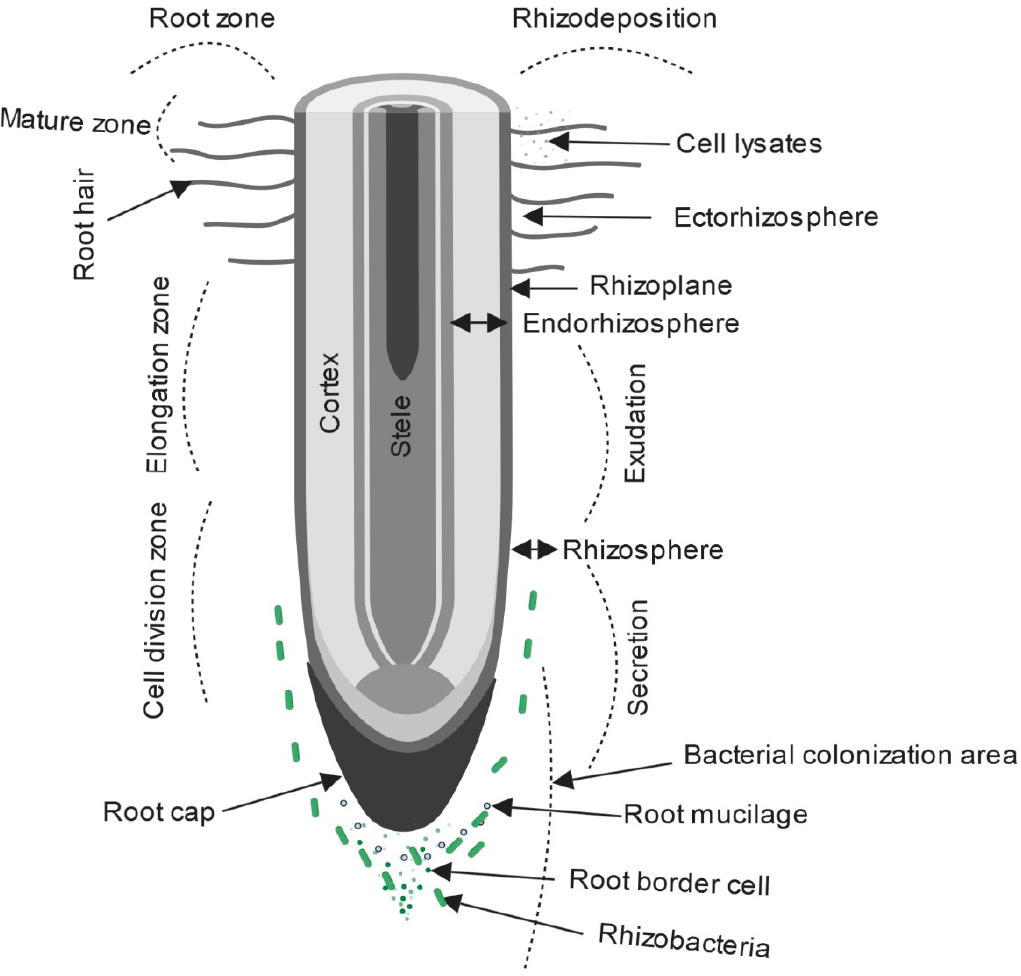
Figure 3. Types of different root zones in the rhizosphere where rhizodeposition, root exudates, and root border cells provide nutrients for PGPR growth and root colonization (created with Biorender.com) [57,105,106].